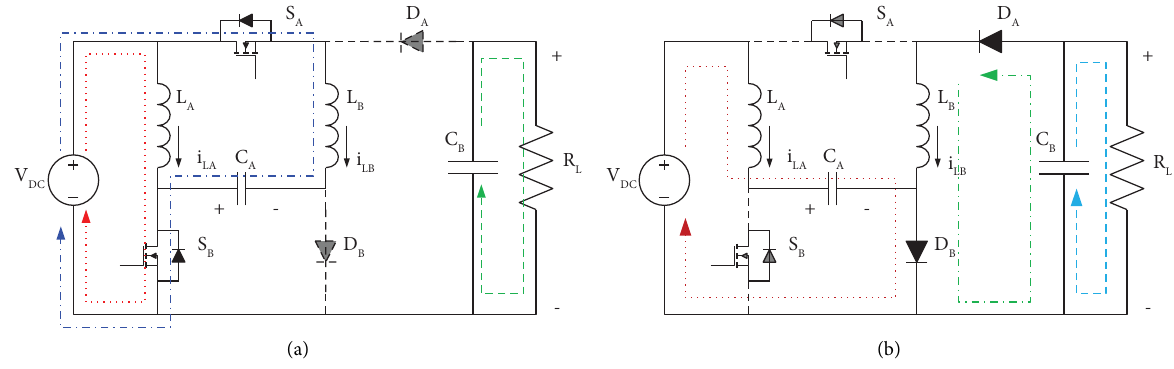
Figure 2: Steady state operating modes of the converter; (a) mode 1 and (b) mode